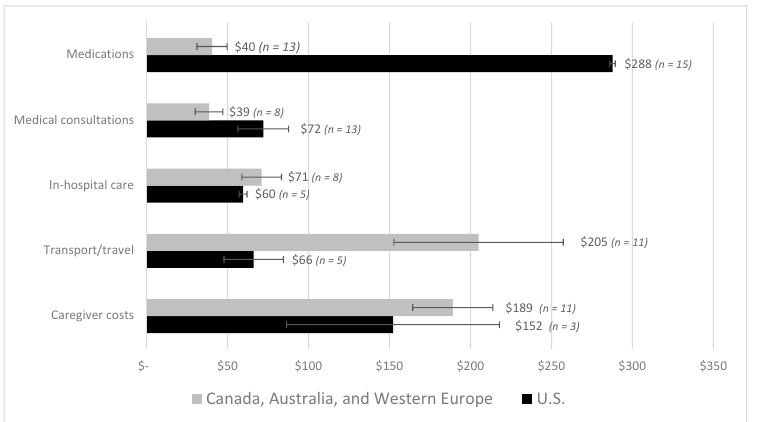
Figure 3. Average monthly out-of-pocket costs per patient by spending categories. Note: The medical expenditure catego- ries were defined as prescription or over-the-counter drugs and medications, home and clinical medical visits, and in- hospital care. The non-medical categories included transport, travel and lodging, and formal and informal caregiver costs (e.g., daycare for pediatric patients). Costs are presented for comparison between the U.S. and countries with universal healthcare coverage. Not enough data was available to estimate costs for low- and middle-income countries. Costs are expressed in 2018 USD. Not enough data were available to stratify these estimates by cancer site.